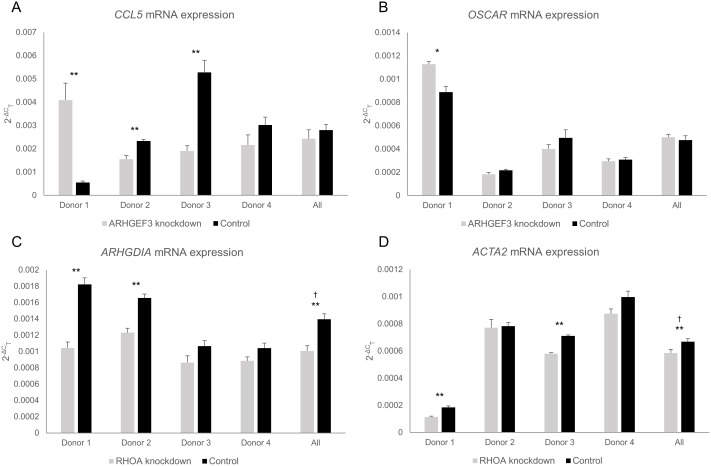
qRT-PCR validation of selected genes in response to ARHGEF3 and RHOA gene knockdown in osteoclast-like cells.(A) CCL5 mRNA expression in osteoclast-like cells. (B) OSCAR mRNA expression in osteoclast-like cells. (C) ARHGDIA mRNA expression in osteoclast-like cells. (D) ACTA2 mRNA expression in osteoclast-like cells. Data displayed as mean 2−ΔC
T ± SEM from three biological replicates. *P<0.05, **P<0.01, † determined as significant by ANOVA.